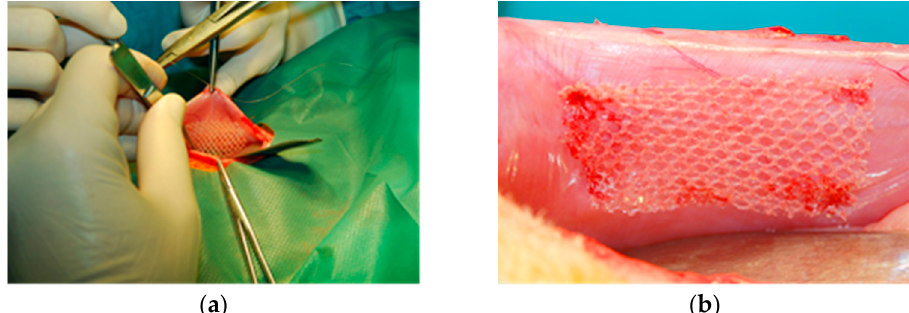
Figure 4. Intrasurgical photography: implantation of the tested implant into the abdominal wall (intraperitoneal position): ( a )—the operative filed view; ( b )—location of the implant.